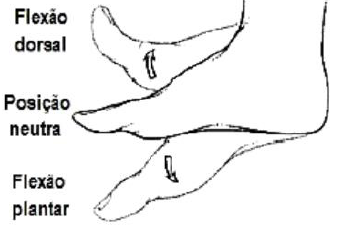
Figure 2. Dorsal Flexion and Plantar Flexion (Caetano